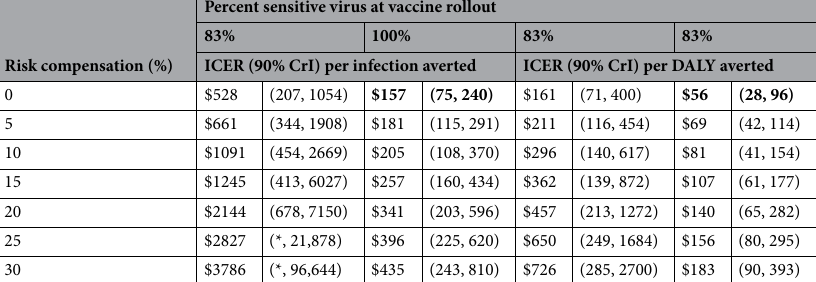
Table 1. Incremental cost-effectiveness ratio (ICER) per infection averted and per DALY averted over 15 years of continuous vaccine implementation. Costs are in 2017 US dollars. The values in bold text (for 100% sensitive virus at rollout) represent a scenario of 50% overall vaccine efficacy but without risk compensation or resistant virus; the overall vaccine efficacy in the 83% sensitive virus at rollout is also 50%, as the per-contact efficacy is 60%. *ICER is dominated (i.e., results in more infections in vaccine scenarios than in the absence of a